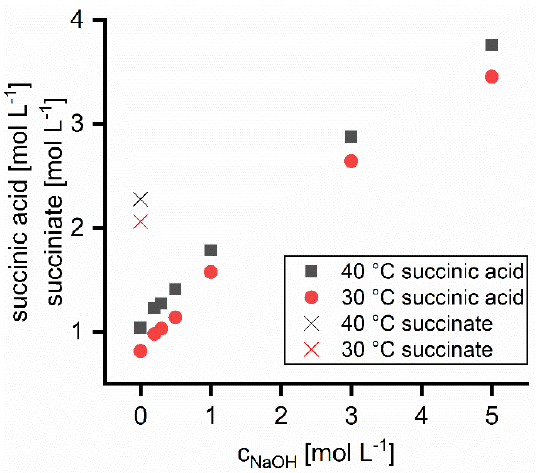
Figure 1. Saturation concentration of succinic acid in NaOH solutions at 30 and 40 °C (dots). Crosses mark the saturation solubility of disodium succinate in water.